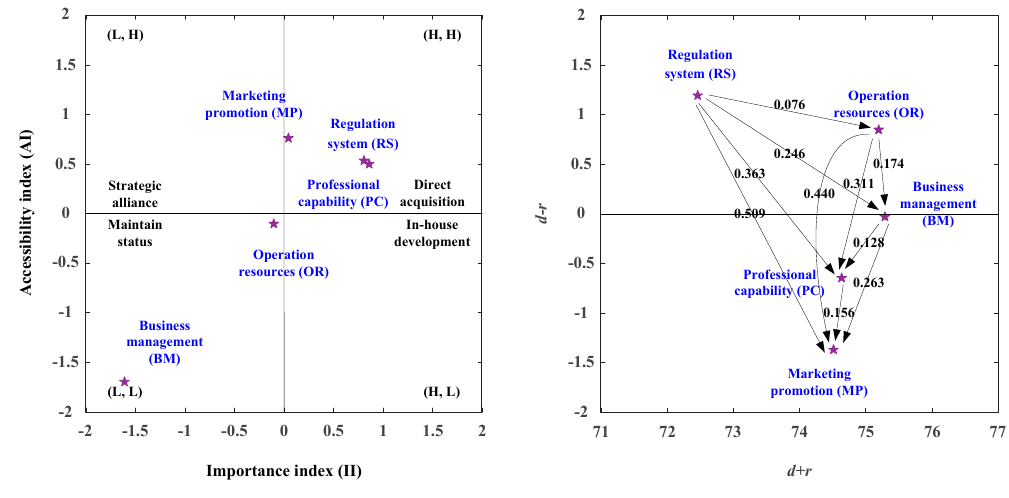
Figure 3. The improvement strategy map of industrial entry.